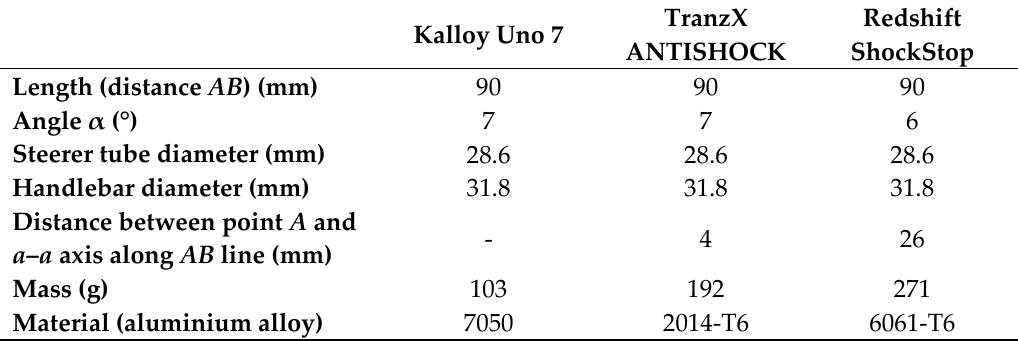
Table 1. Technical data for the tested stems, with reference to Figure 1d.